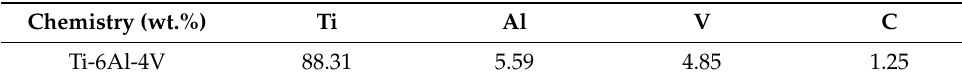
Table 1. Chemical compositions of Ti-6Al-4V alloy.